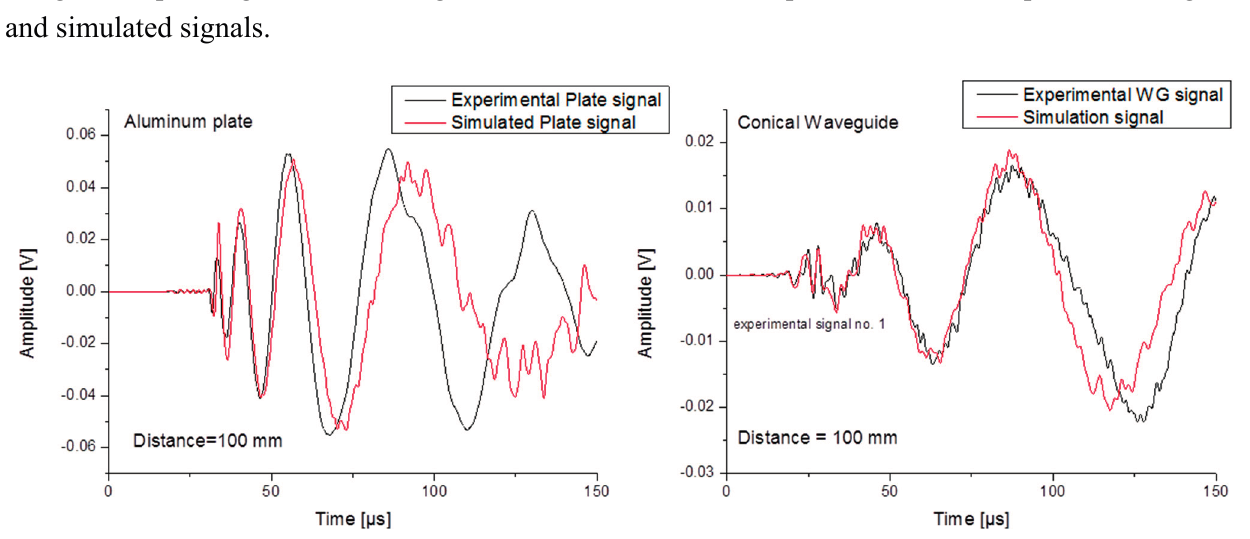
Figure 6. Experimental results vs. simulation results for ( a ) plate signal-reference ( b ) WG